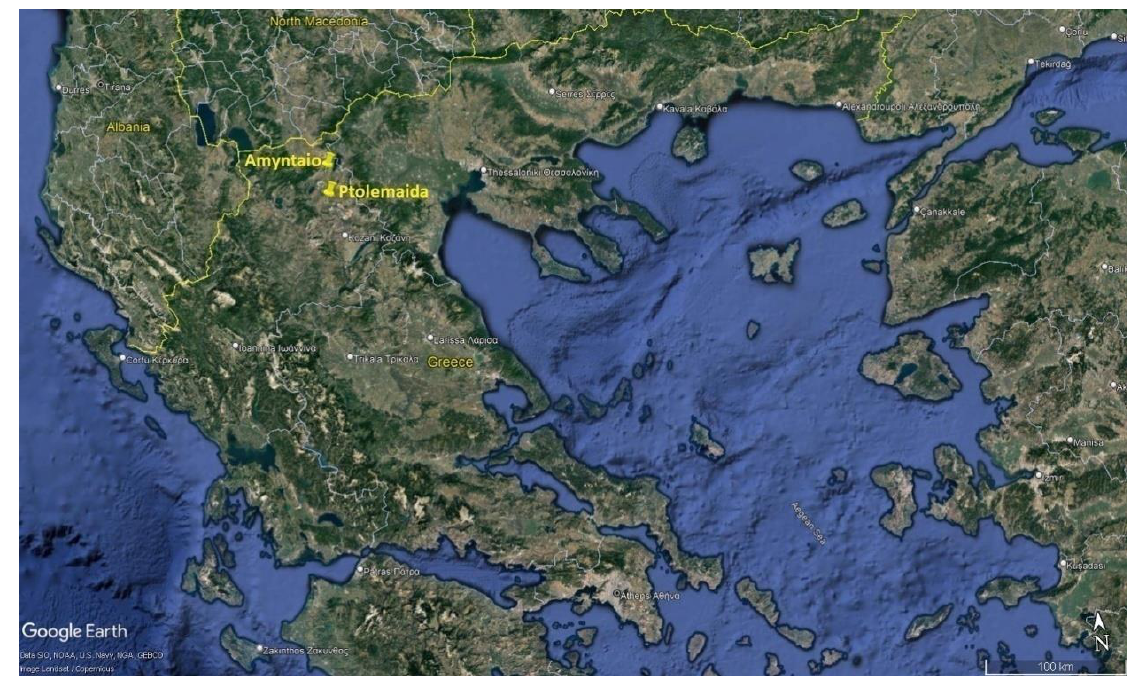
Figure 1. Study country (locations of the two study areas are marked with yellow push pins).